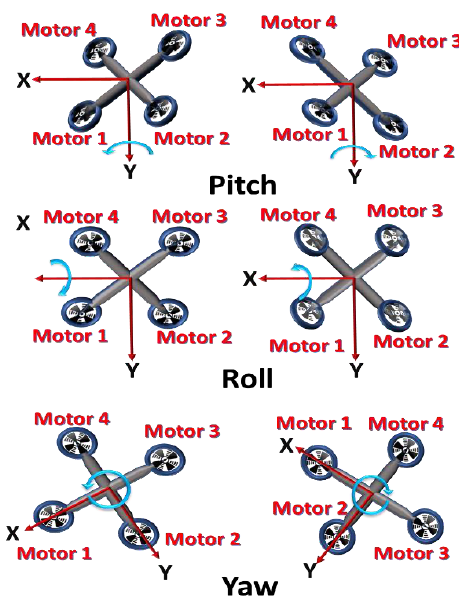
Figure 3. Quadcopter basic rotations